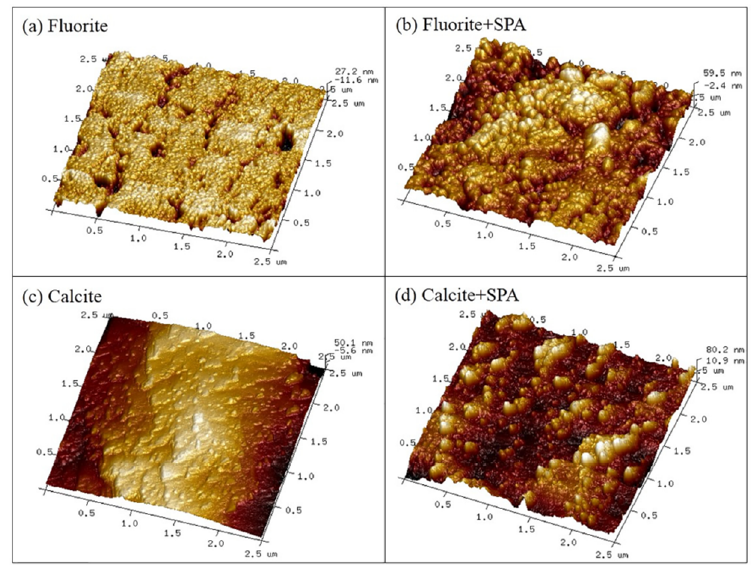
Figure 3. AFM 3D images of fluorite ( a ), fluorite treated with SPA ( b ), calcite ( c ) and calcite treated with SPA( d ) [74].